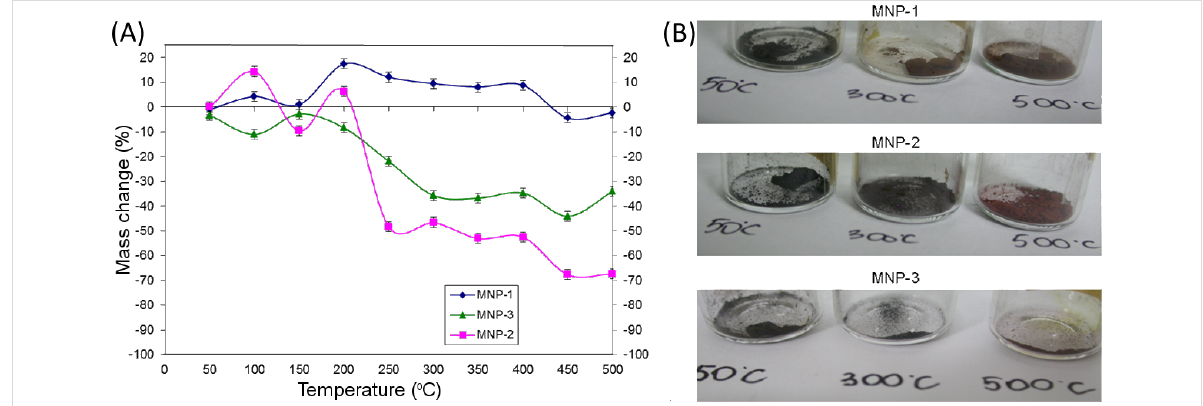
Figure 1: (A) Mass change of the nanoparticle powders (%) with respect to the temperature variation. (B) Color change of the nanoparticles after